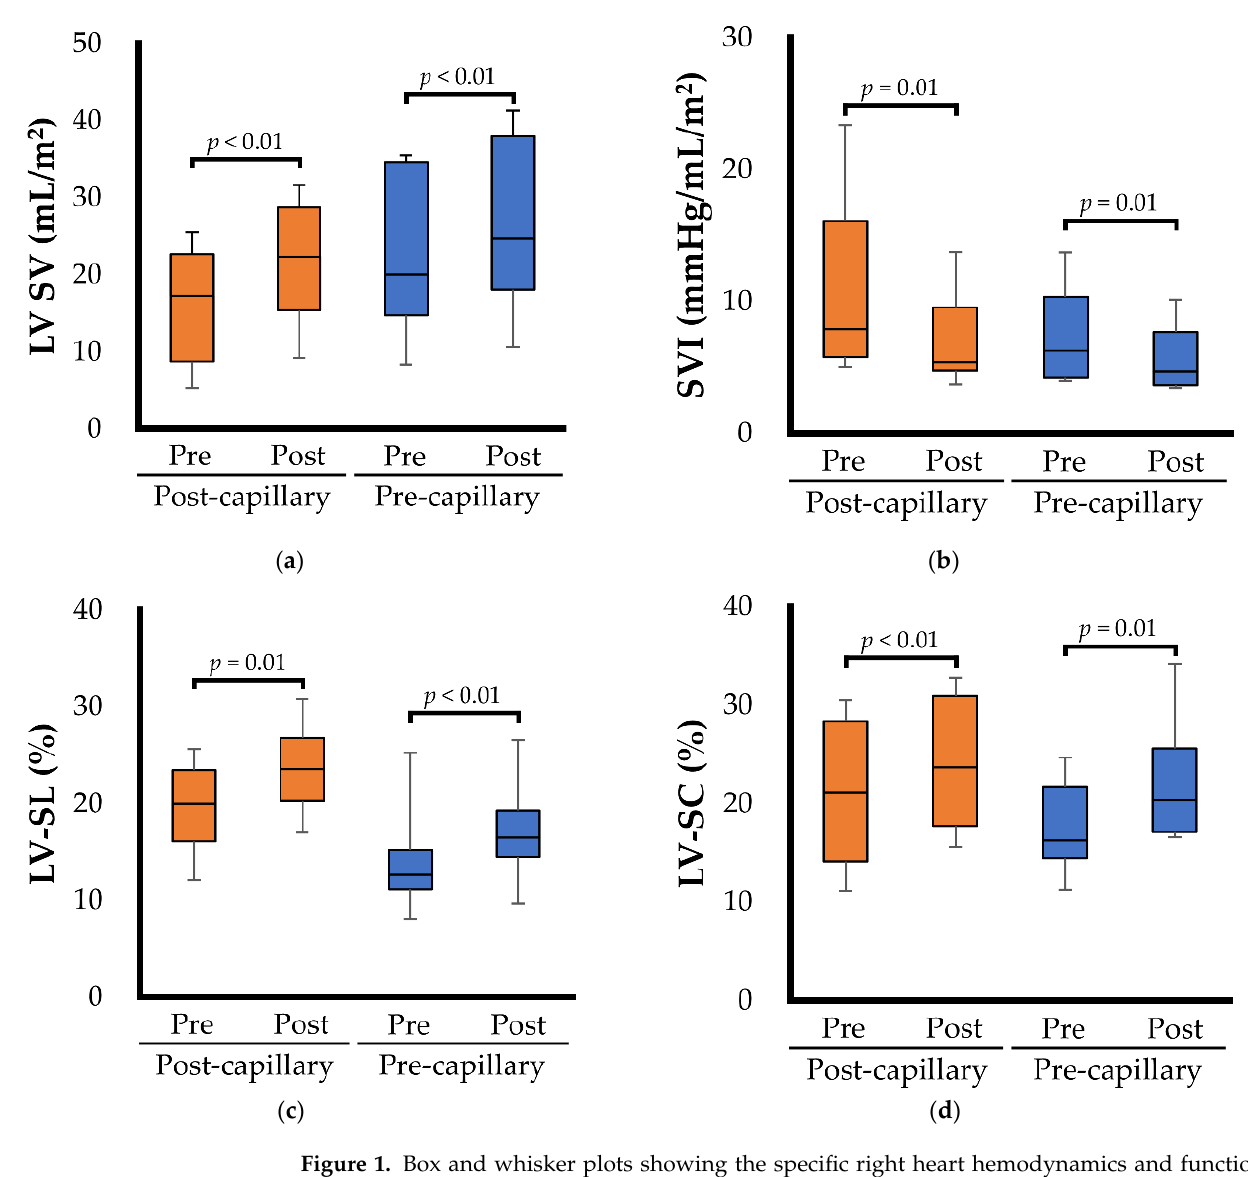
Figure 1. Box and whisker plots showing the specific right heart hemodynamics and functional echocardiographic variables before (Pre) and after (Post) beraprost sodium administration. The bottom of the box is 25th percentile, the center line is the median, the top of the box is 75th percentile, and the whiskers are the range. The blue box represents the results for dogs with pre-capillary pul- monary hypertension; the orange box represents the results for dogs with post-capillary pulmonary hypertension. ( a ) Left ventricular stroke volume (LV SV); ( b ) Systemic vascular impedance (SVI); ( c ) Left ventricular longitudinal strain (LV-SL); ( d ) Left ventricular circumferential strain (LV-SC). Table 3. Results of echocardiographic variables for left heart morphology and function in dogs with post-capillary and pre-capillary pulmonary hypertension before and after beraprost sodium